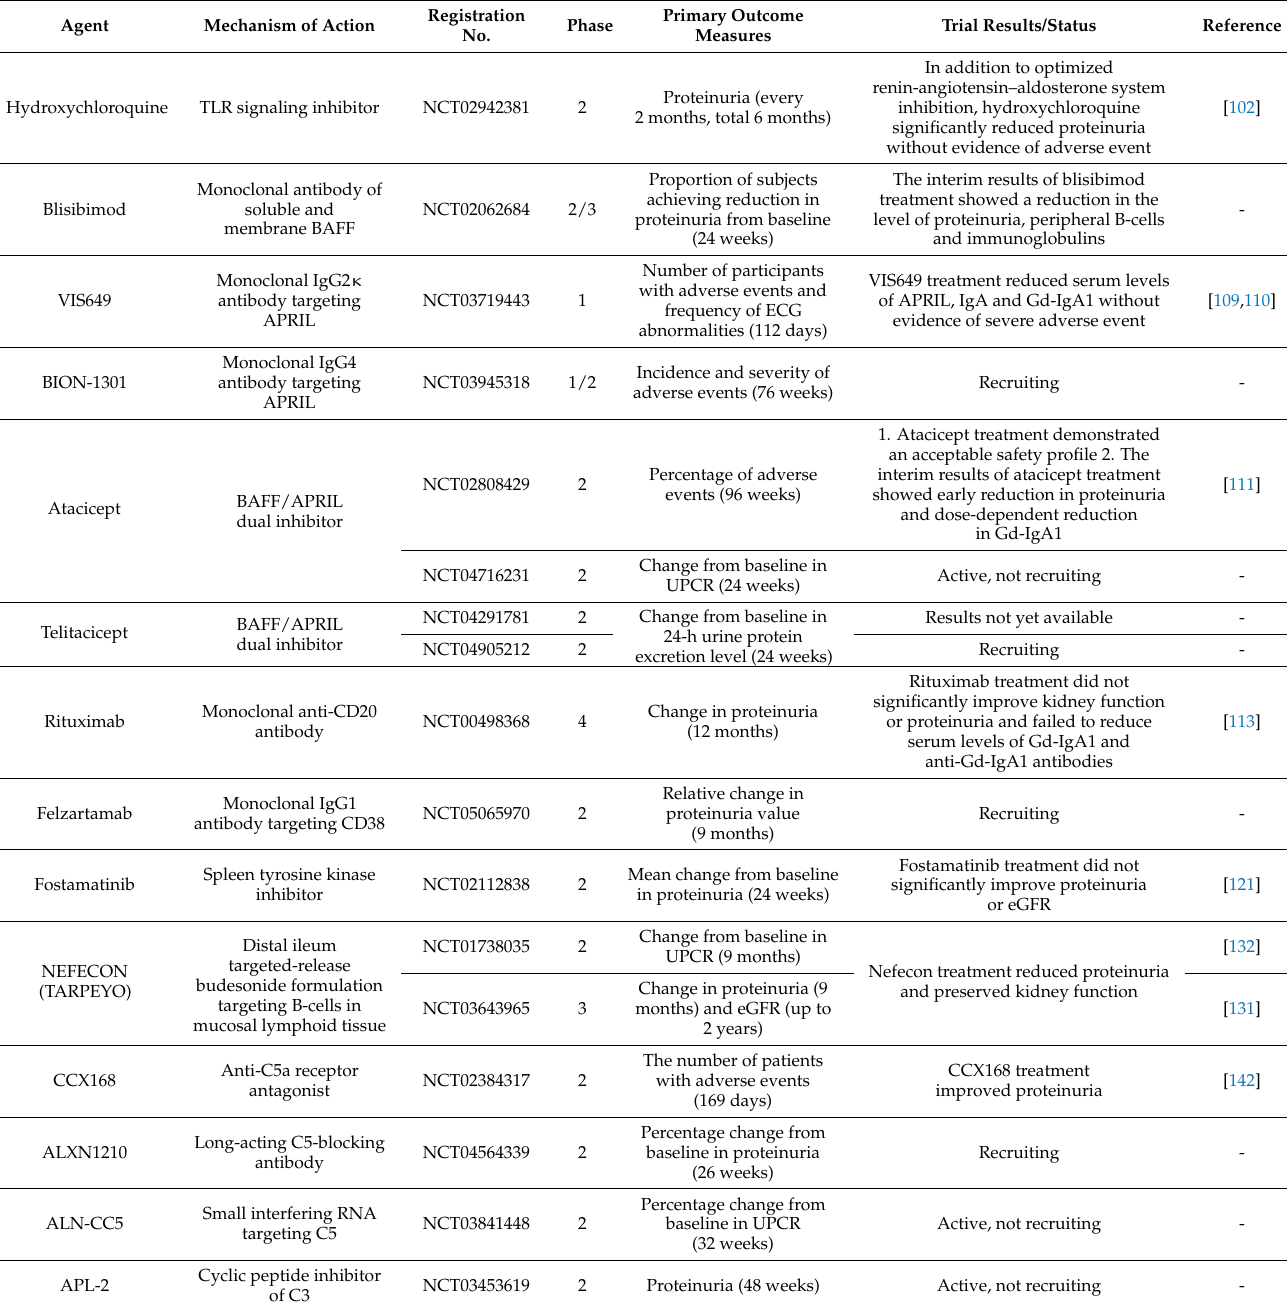
Table 3. Clinical trials assessing targeted therapies in